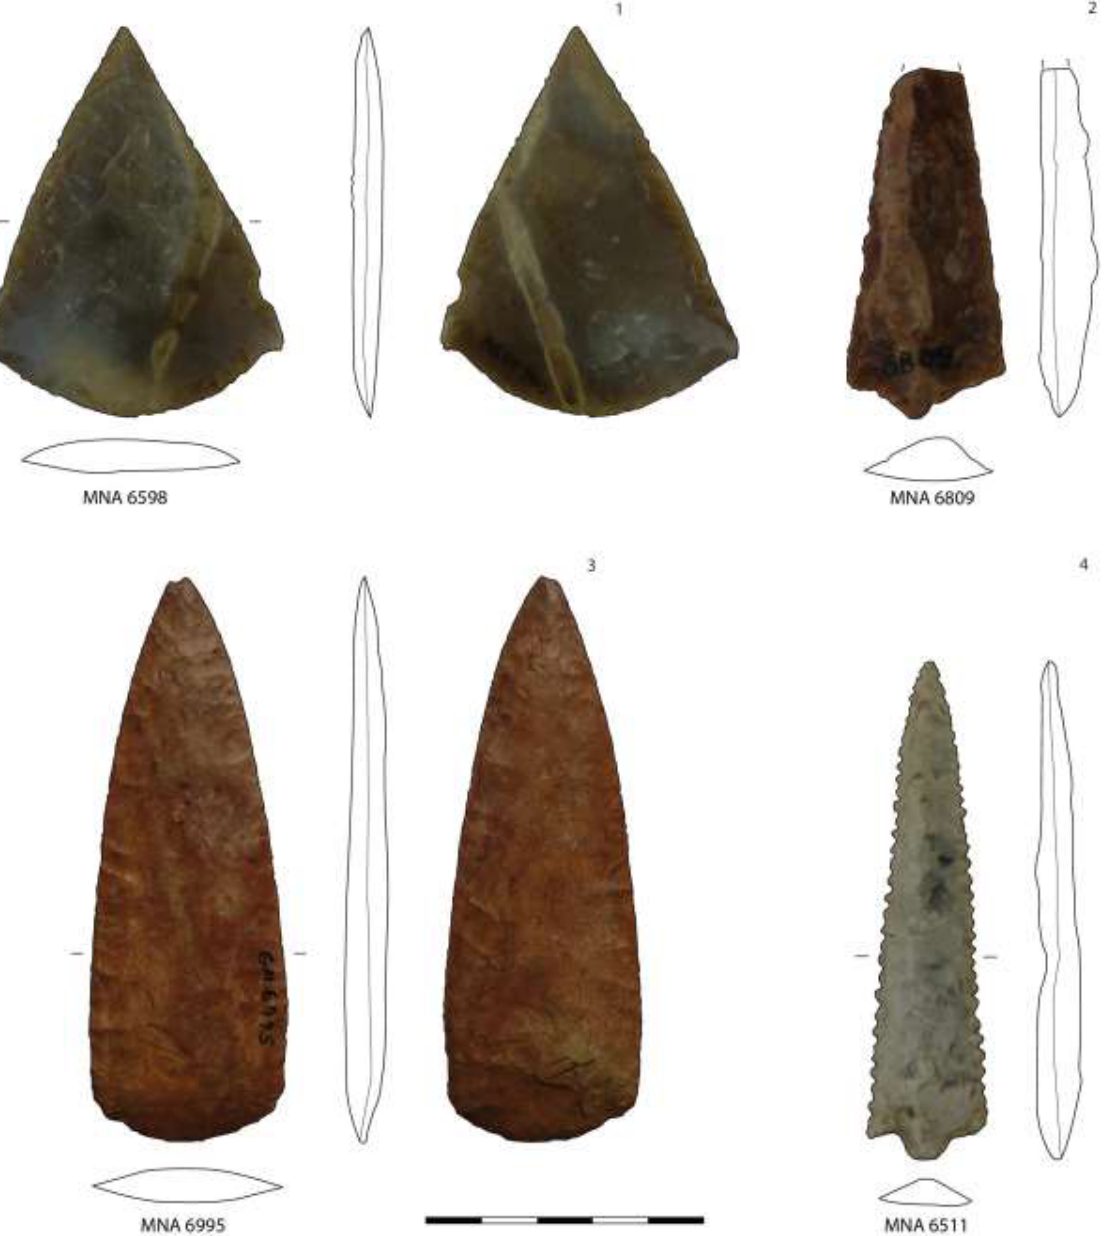
Figure 12. The variability of large bifacial points is evident. 1: “halberd”; 2 and 4: bifacial points that resemble the shape of arrowheads; 3: bifacial point with “rounded” base. The scale bar is 5 cm long (in 1 cm